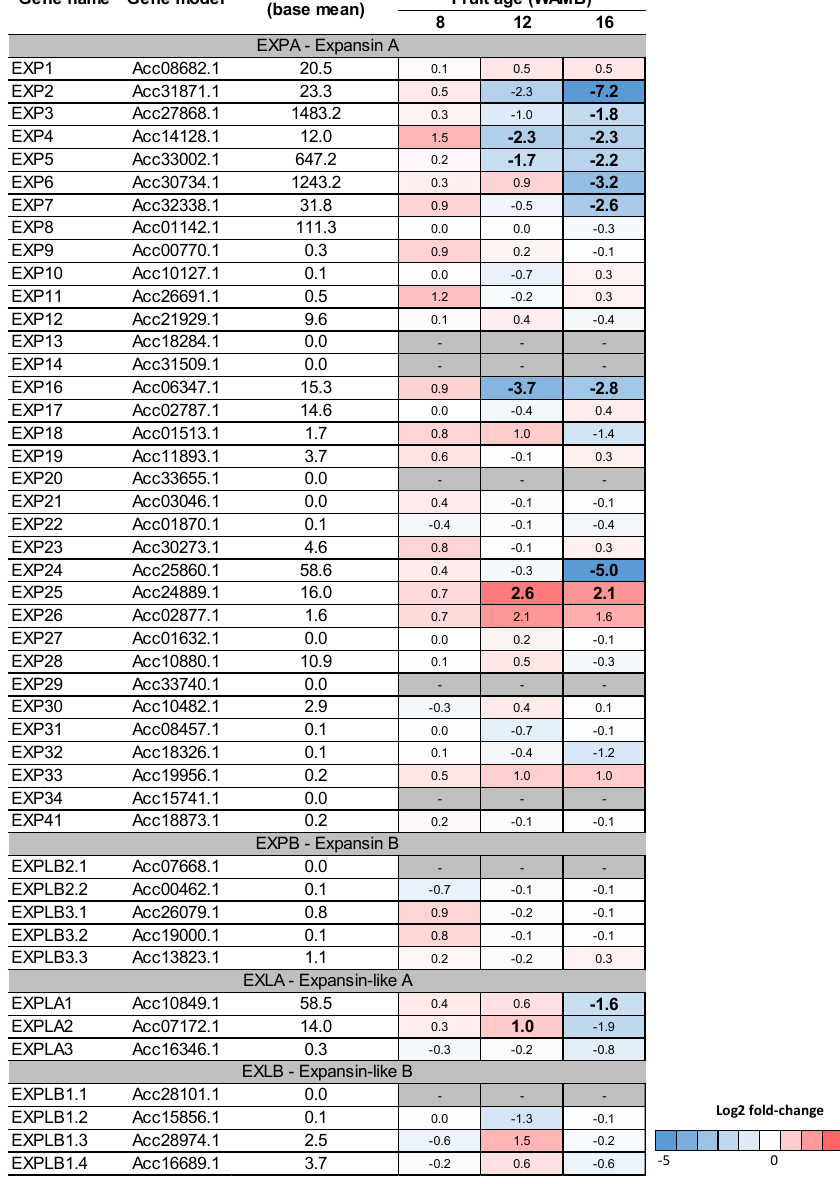
Figure 8. Heat-map of kiwifruit expansin genes. DESeq comparison of low carbohydrate supply (carbon starvation) versus high carbohydrate supply treatments. Differentially expressed genes were identified based on the DESeq analysis from Nardozza et al. [6]. For each gene, the expression level (base mean) and the log2 fold-change are presented. Fruit age is in weeks after mid bloom (WAMB). Bold figures mean differences are significant for adjusted p < 0.05 (DESeq analysis).